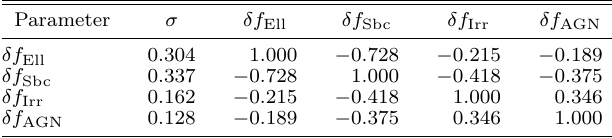
Figure 5. The SED standard deviation ( (cid:112) Σ( ν,ν )) for all galaxies in the sample. The vertical dashed line highlights the effective wavelength of the normalization luminosity, which is the Johnson-Cousins B filter for this plot only. Note the there are no units given for Σ( ν,ν (cid:48) ) because the normalization luminosity used, L N , fits the standard practice in astronomy of it’s weighting function, w N ( ν ), having the units needed to make L N a weighted mean of L ν , that is w N ( ν ) has units [Hz − 1 ]. Table 7 Covariance Matrix of Blue SED